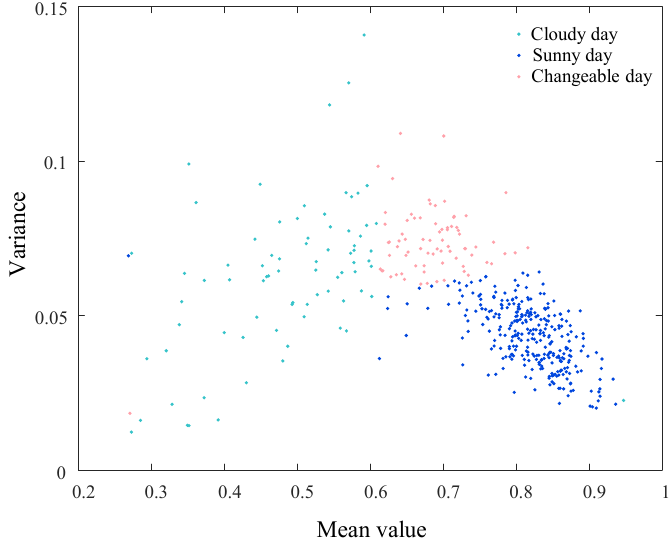
Figure 6. Results of the weather clustering.